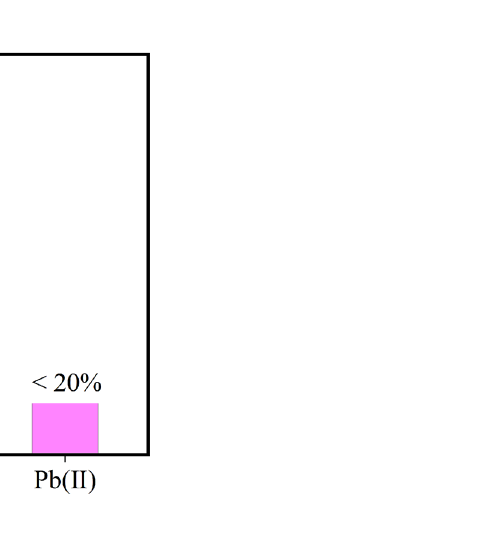
Figure 6. Desorption rate of heavy metal ions by